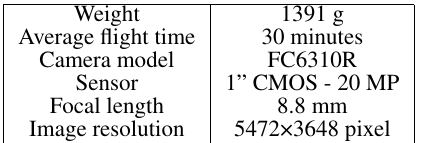
Table 1. Technical specifications of the DJI Phantom 4 RTK.